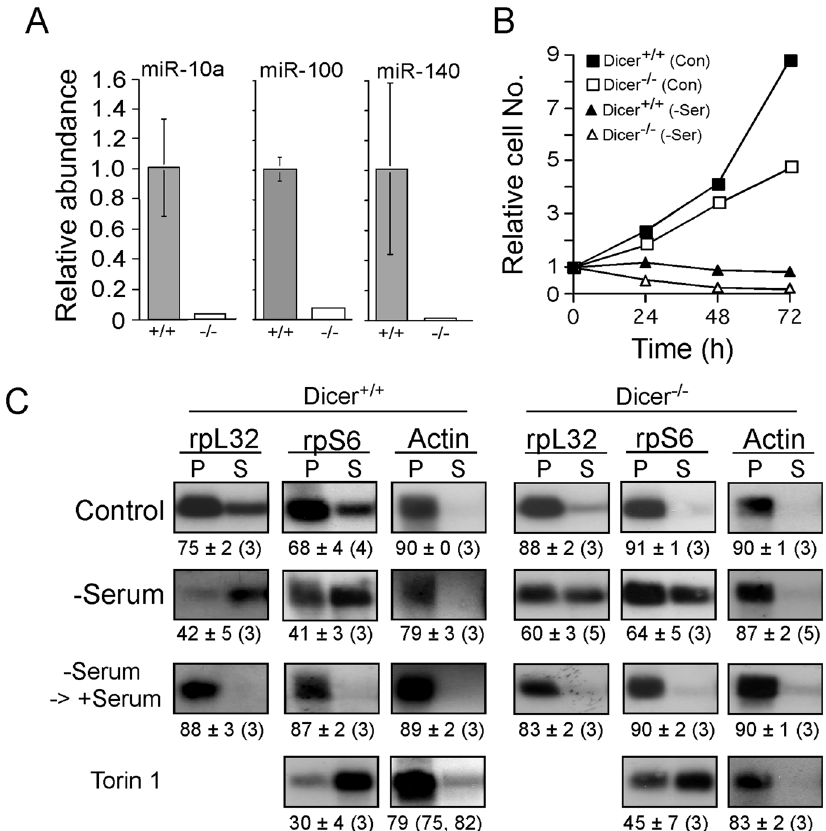
Figure 8. micorRNAs are dispensable for serum-induced translational activation of TOP mRNAs. (A) Total RNA was prepared from Dicer + / + and Dicer 2 / 2 MEFs and the relative abundance of the indicated miRs was assessed by quantitative PCR. The abundance of each miR in Dicer 2 / 2 MEFs was normalized to that in Dicer + / + MEFs, which was arbitrarily set at one. (B) Dicer + / + and Dicer 2 / 2 MEFs were seeded in 96-well plates at a density of 4 6 10 3 cells per well. Cells were either untreated (Con) or serum starved ( 2 Ser) for the indicated amount of time. Proliferation was monitored by the methylene blue staining protocol [68]. Absorbance measured 24 h after platting, set arbitrarily at 1, and measured at later time points (average 6 SEM [ n =5] for each time point) was normalized to that value (note that the error bars are are smaller than the size of the symbols). (C) Dicer + / + and Dicer 2 / 2 MEFs were either untreated (Control), serum starved ( 2 Serum) for 48 h or serum starved for 48 h and then serum refed for 3 h ( 2 Serum R + Serum), or treated with 50 nM Torin 1 for 2 h. Cells were harvested and subjected to polysomal analysis using the indicated